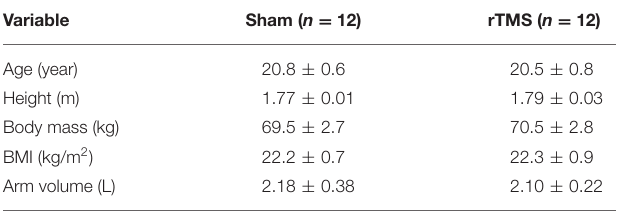
TABLE 1 | Subject characteristics at